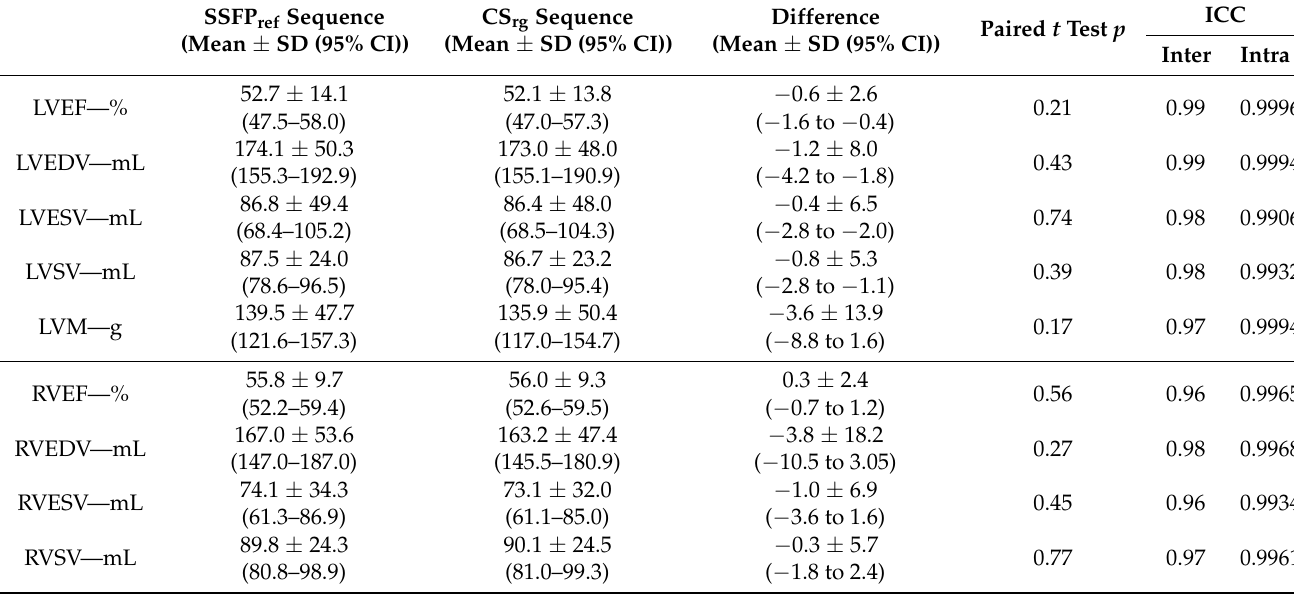
Table 4. Functional parameters segmented on both the reference steady-state free-precession and retrogated compressed- sensing